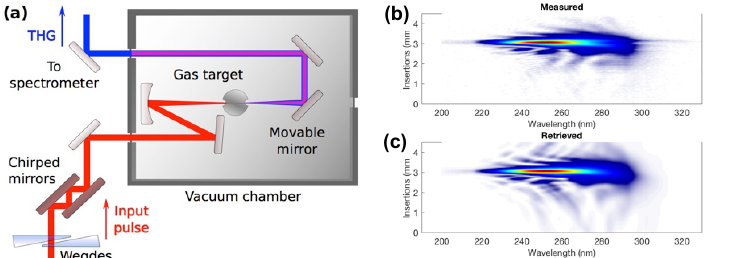
Fig. 1. (a) Setup for on-target THG d-scan and simultaneous HHG in a gas target. (b) Measured and (c) retrieved THG d-scan traces for